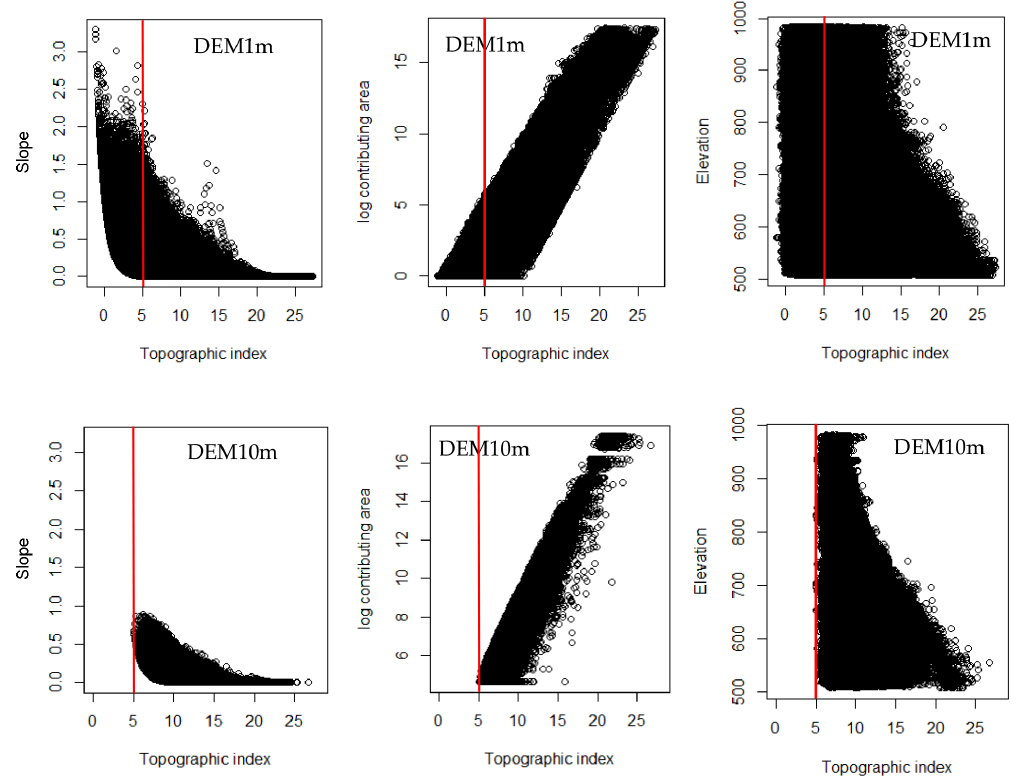
Figure 12. Relationships of topographic index with slope, upslope contributing area and elevation with two different DEM resolutions: 1 and 10m (red lines are used as reference to compare the two DEM